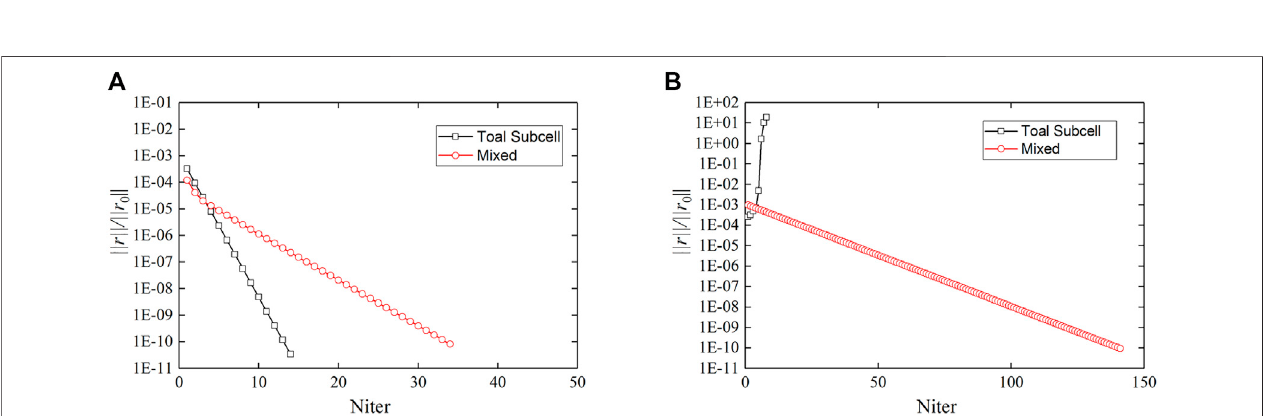
FIGURE 11 | Displacement results calculated using mixed scheme with irregular mesh (the displacement is scaled by a factor of 2, Units: m). (A) horizontal displacement; (B) vertical displacement.